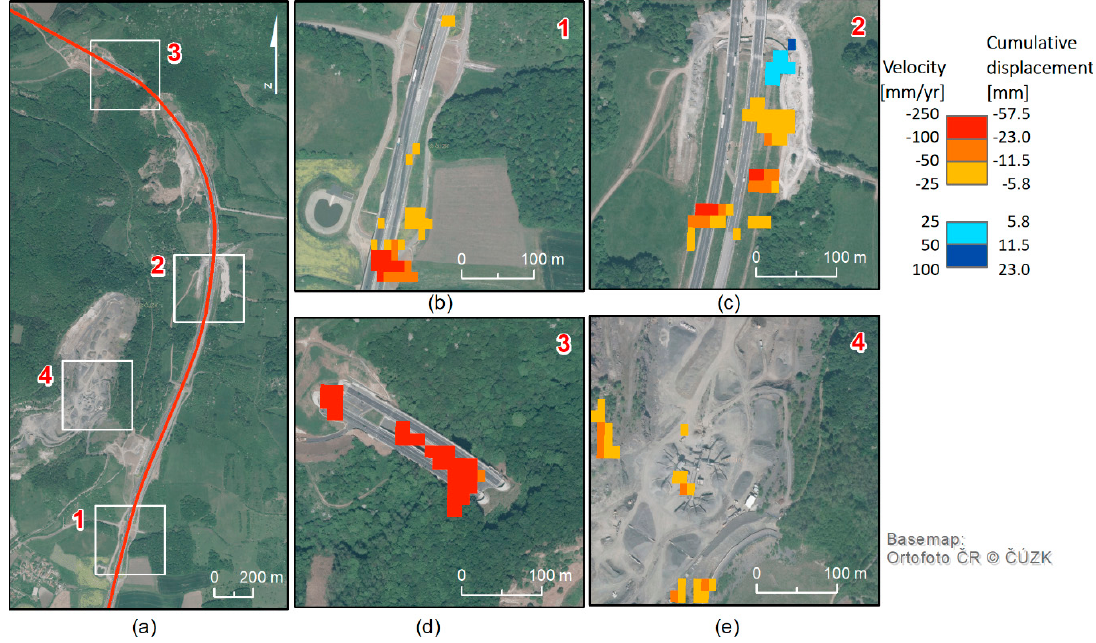
Figure 9. ( a ) Overview of the four sites with detected subsidence: 1: Area of highway embankment between Je č ky Bridge and Dobkovi č ky Bridge; 2: Prackovice Bridge; 3: Area between two highway tunnels (“Prackovice” and “Radej č ín”); 4: Dobkovi č ky quarry. ( b – e ) Cumulative vertical displacement (mm) during the given period from 22 February 2017 to 17 May 2017 and the recalculated subsidence / uplift velocity (mm / year) obtained by using single-pair